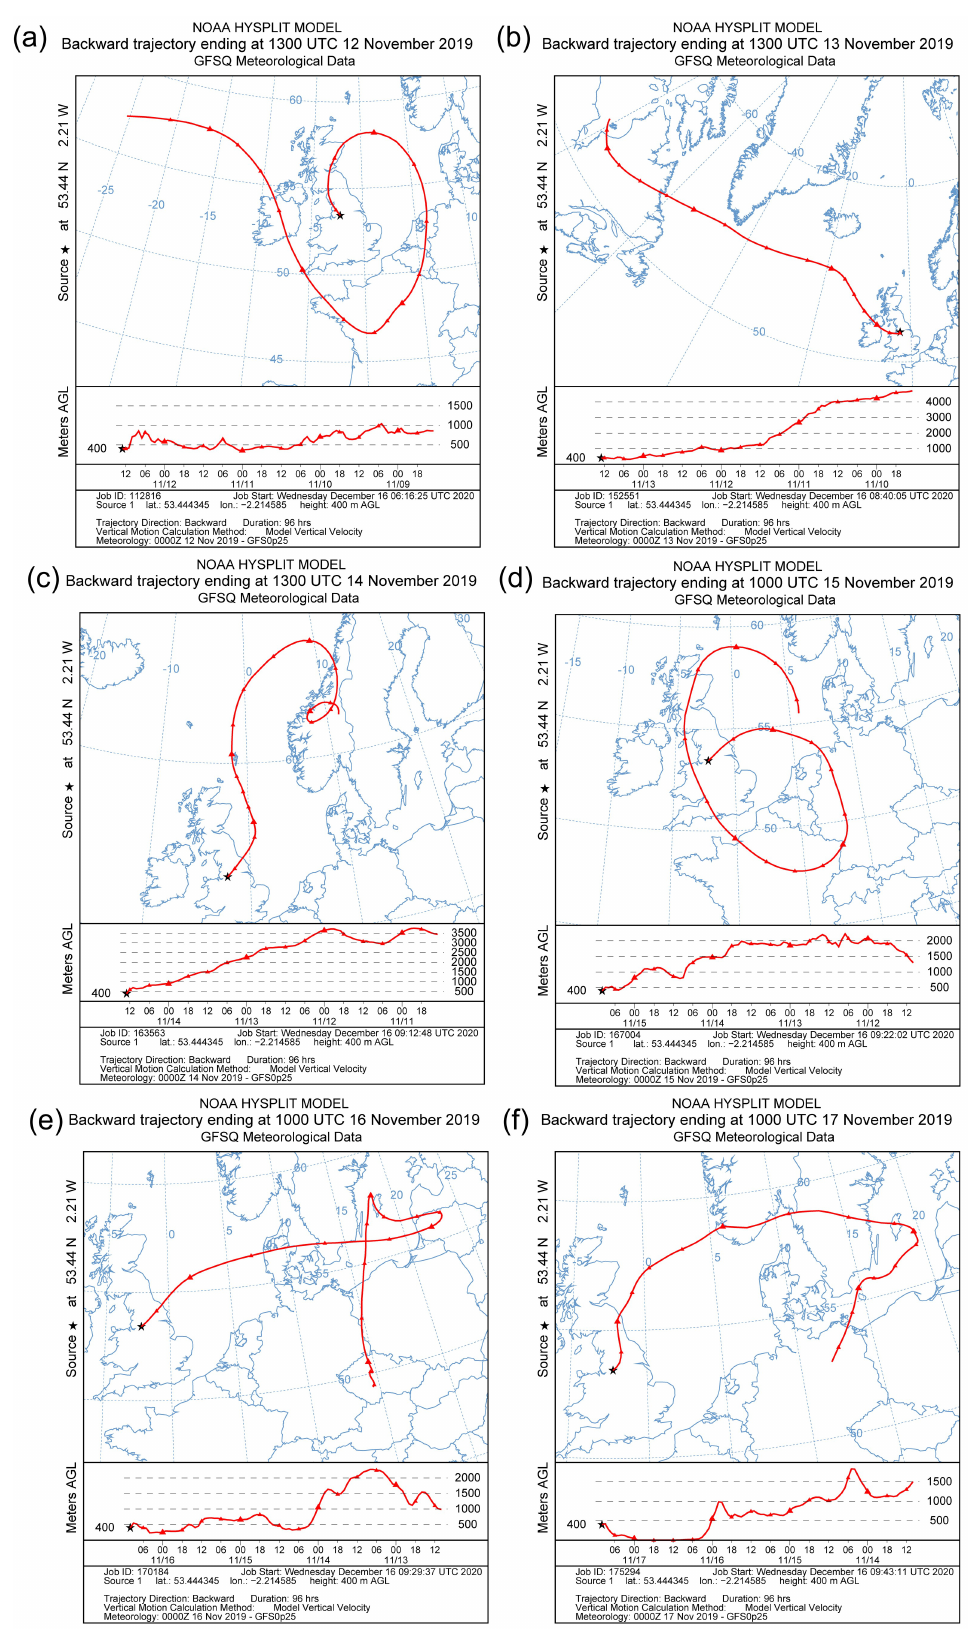
Figure 2. 96 h HYSPLIT Lagrangian back trajectories of air at the start point of each sample collected in November 2019. ( a ) “FIRS1_7”, ( b ) “FIRS1_8”, ( c ) “FIRS1_9”, ( d ) “FIRS1_12”, ( e ) “FIRS1_13” and ( f )